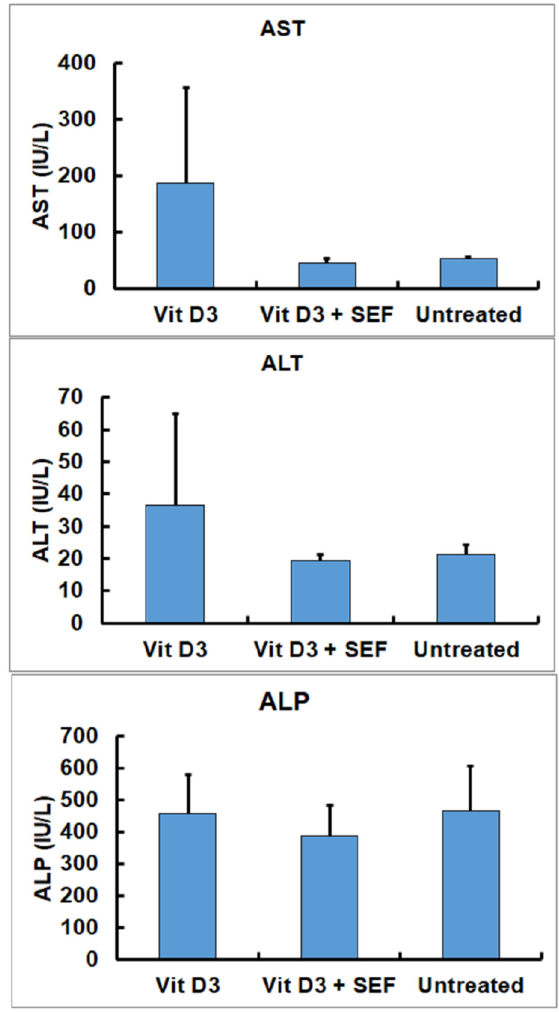
Figure 4. Serum biochemical findings in hepatic functional enzymes (AST, ALT, and ALP). AST and ALT activities tended to increase in the Vit D 3 -treated group.